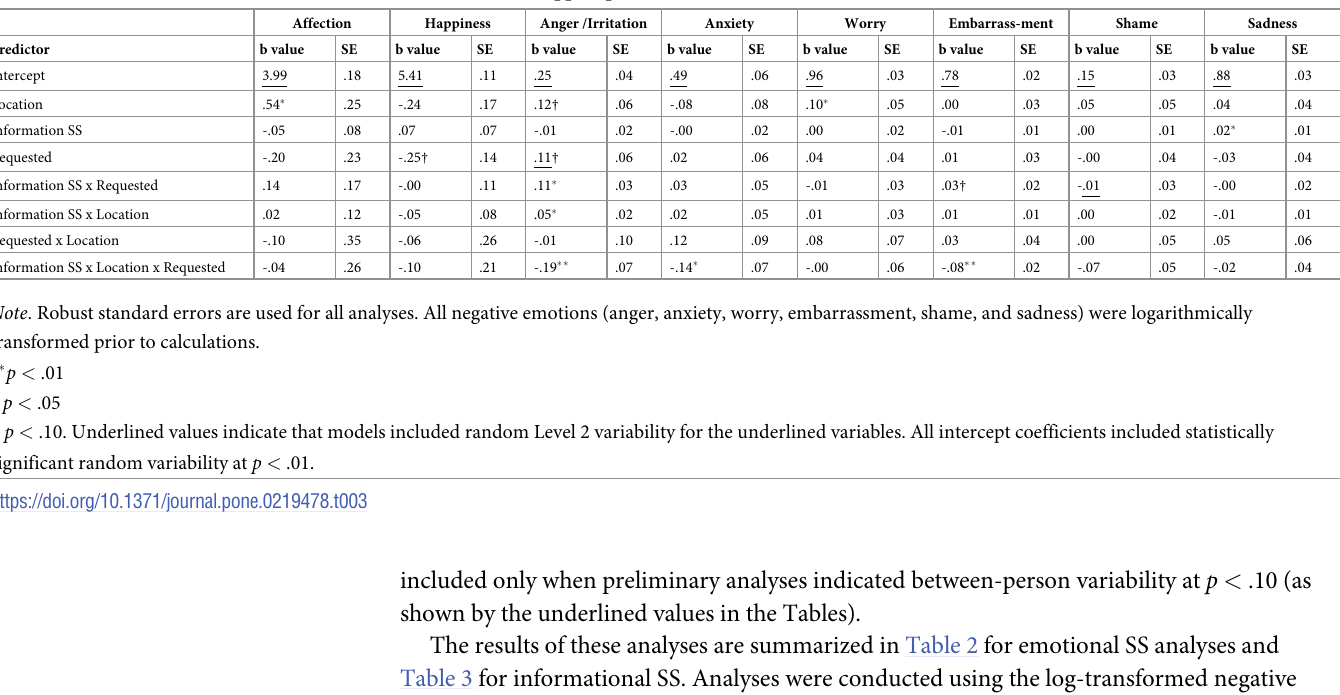
Table 3. Culture and emotional correlates of informational social support